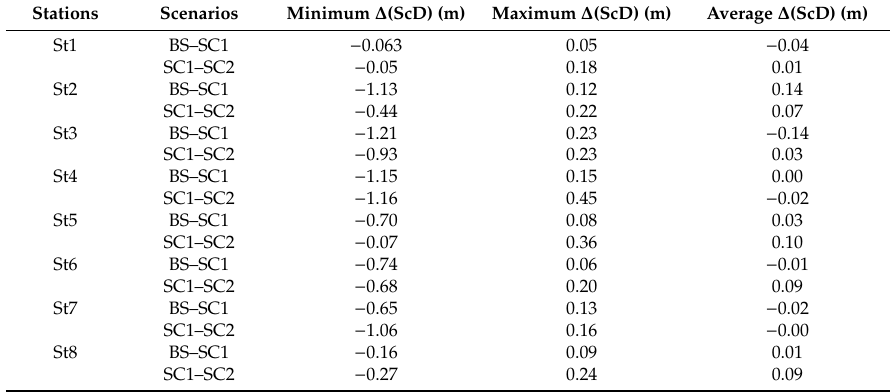
Figure 13. Time series of the Secchi depth difference, Δ( ScD), between the scenarios (BS–SC1 and SC1–SC2), for September 2000, and the lagoon stations: ( a ) St1, ( b ) St2, ( c ) St3, ( d ) St4, ( e ) St5, ( f ) St6, ( g ) St7 and ( h ) St8.